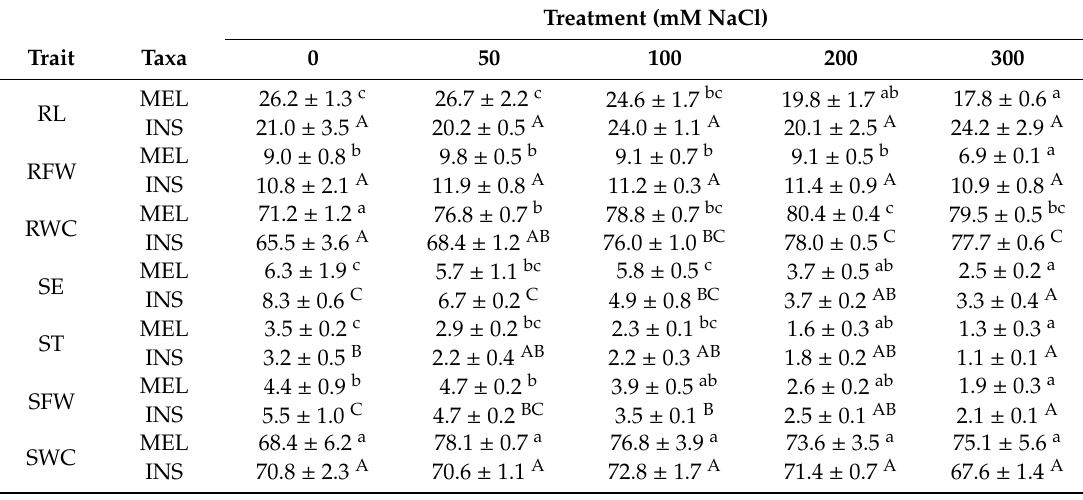
Table 2. Growth responses and photosynthetic parameters in Solanum melongena (MEL) and S. insanum (INS) after 25 days of treatment with the indicated NaCl